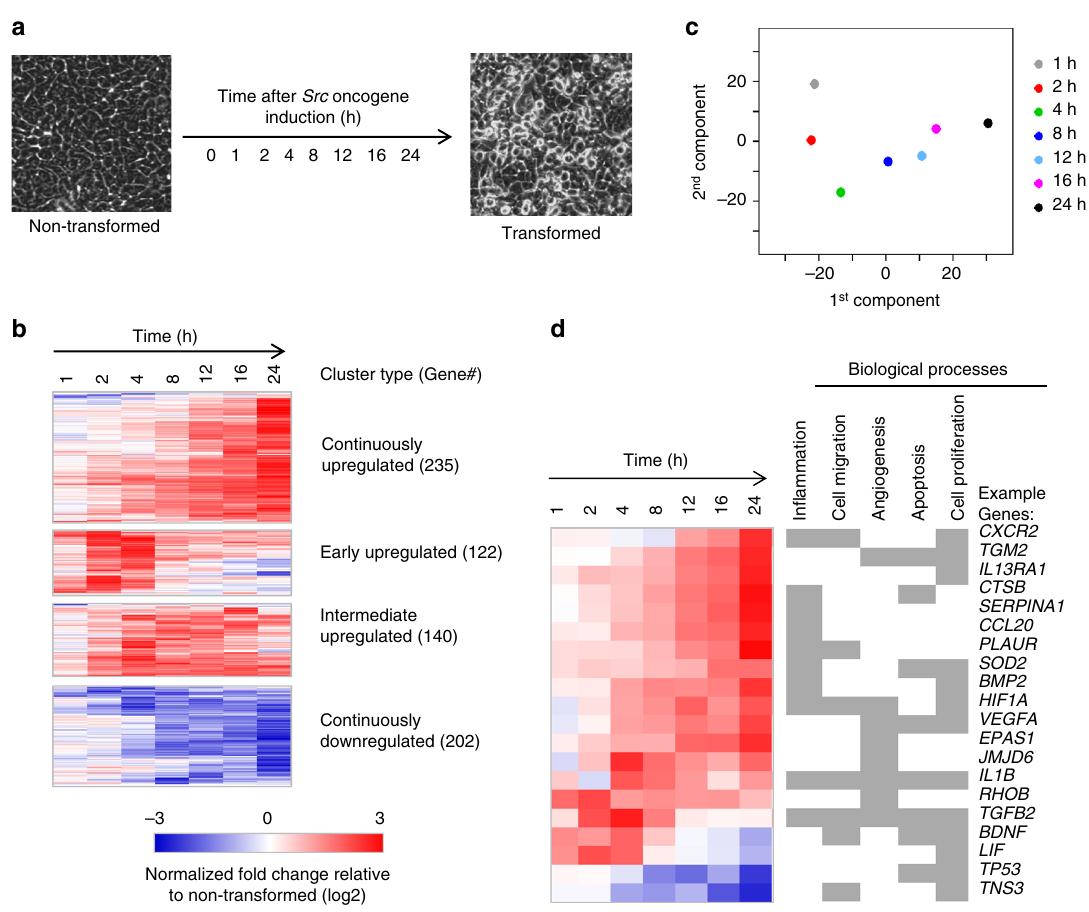
Fig. 1 Differential gene expression during transformation. a Time-series of cells treated with tamoxifen for 0 h, 1 h, 2 h, 4 h, 8 h, 12 h, 16 h, and 24 h. b The K- mean clustering of 699 differentially expressed genes into four coherent clusters. c Principal component analyses of differential RNA expression pro fi le. d Example genes in pathways enriched with differentially expressed genes. One gene may regulate several oncogenic processes as indicated in gray